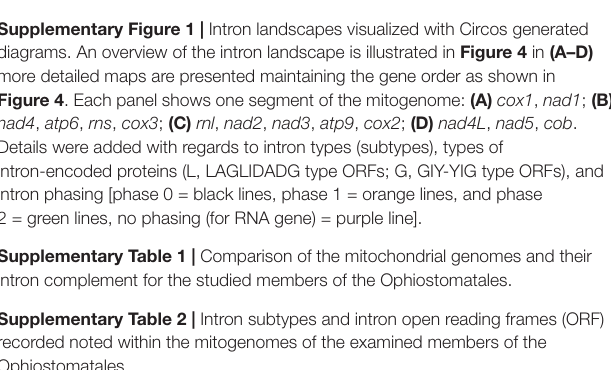
Supplementary Figure 1 | Intron landscapes visualized with Circos generated diagrams. An overview of the intron landscape is illustrated in Figure 4 in (A–D) more detailed maps are presented maintaining the gene order as shown in Figure 4 . Each panel shows one segment of the mitogenome: (A) cox1 , nad1 ; (B)